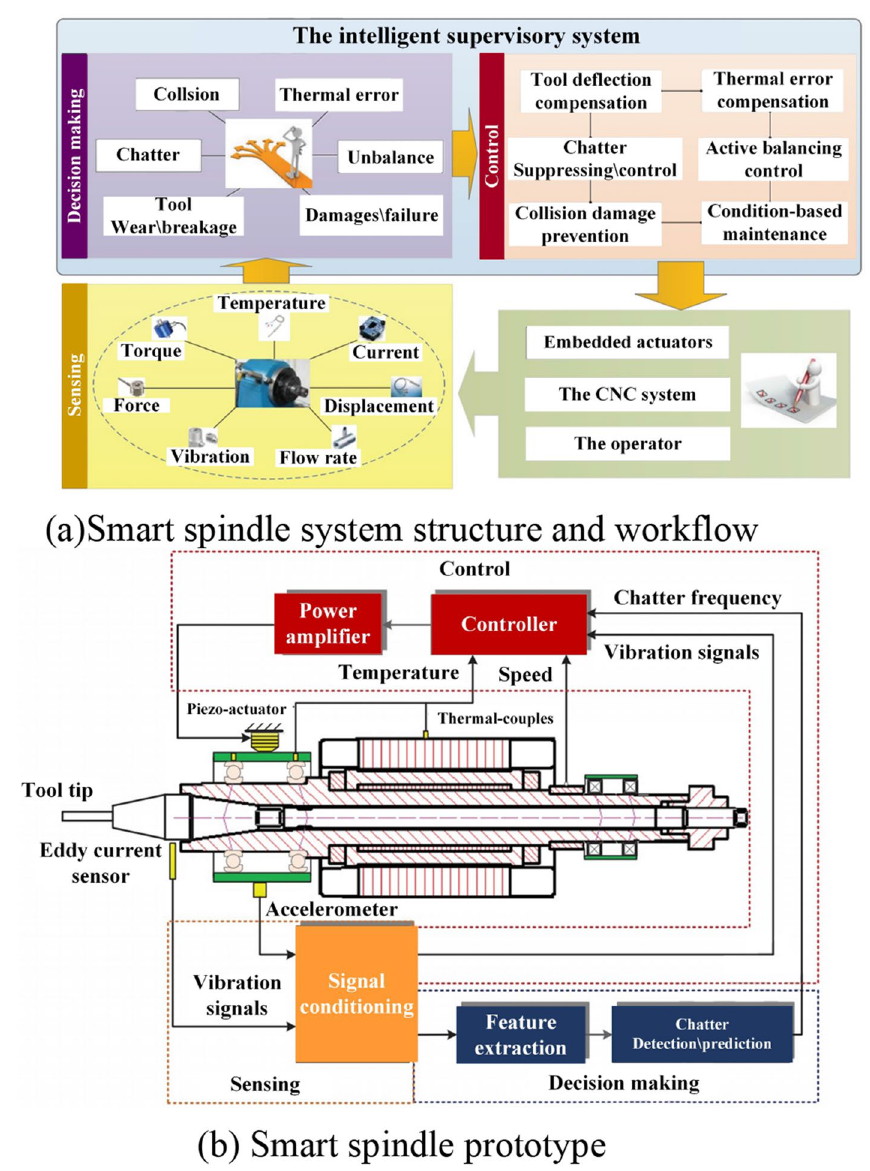
Fig. 13 a Smart spindle system structure and workflow; b Smart spindle prototype